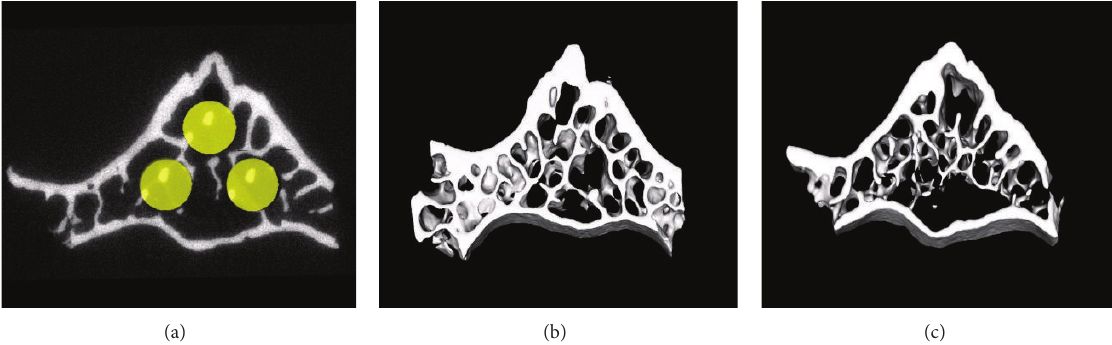
Figure 3: Micro-CT images of rat vertebral bodies. (a) Selection of the volume of interest (VOI) in the vertebral body for micro-CT analysis (yellow circles), with 3 VOIs in each vertebral specimen selected to contain the sites of indentations. Compared with sham operation (b), ovariectomy (c) results in pronounced trabecular deterioration of trabecular microstructure of the vertebral